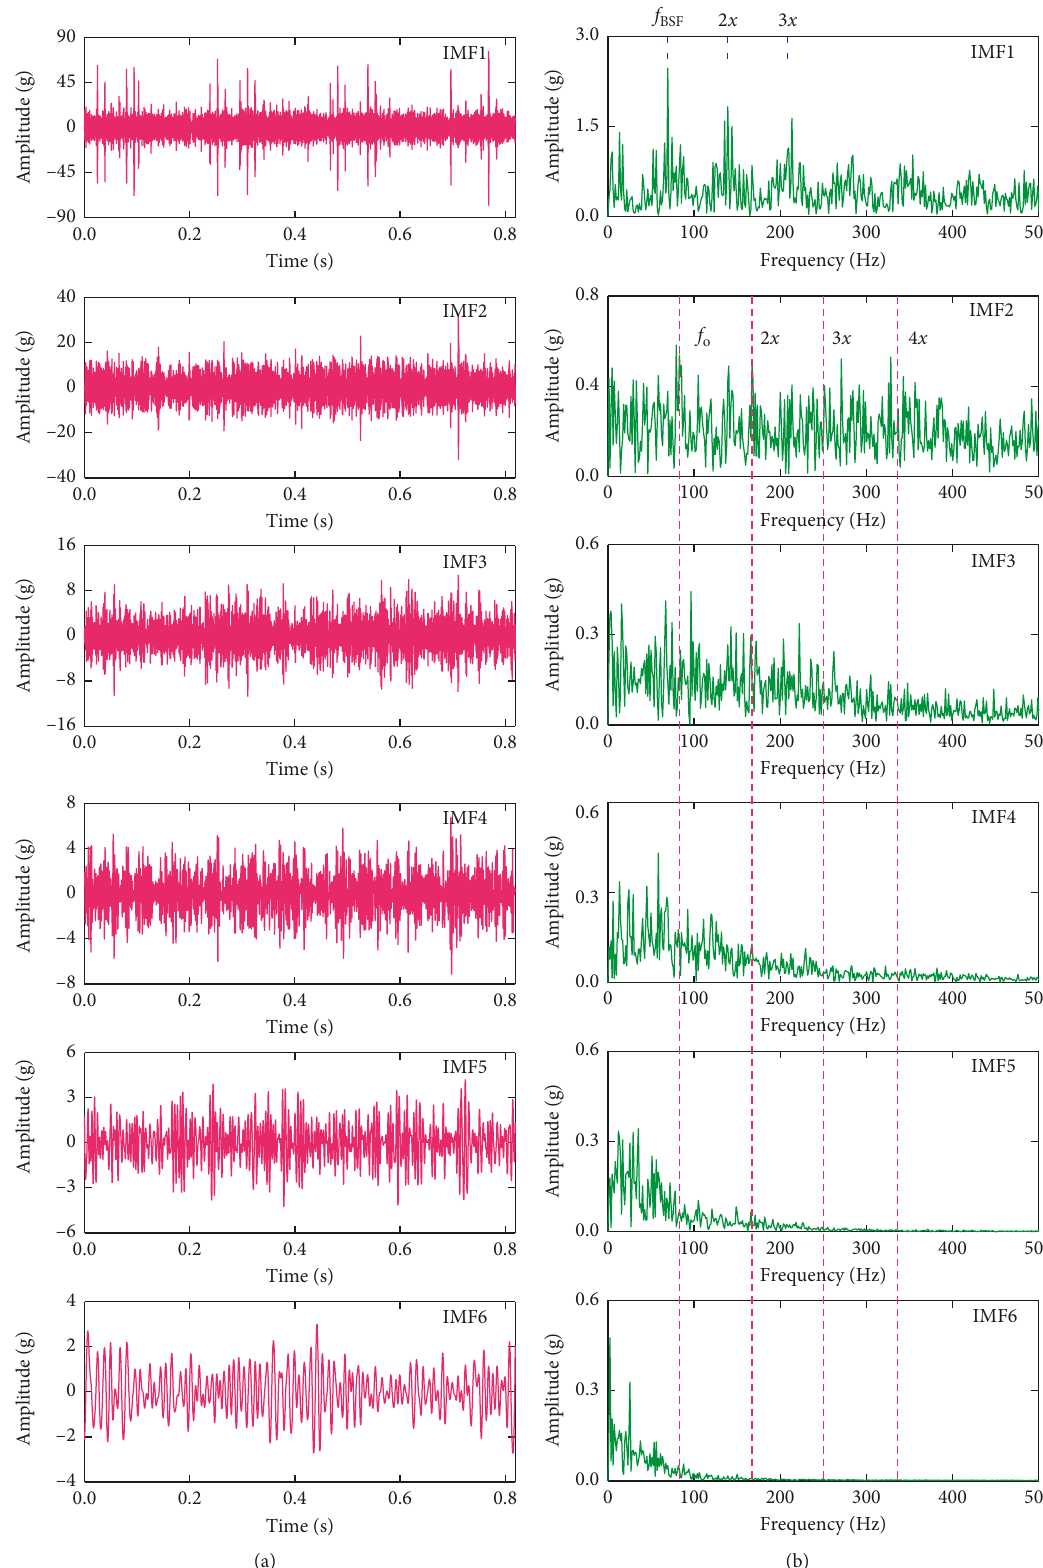
Figure 15: Results obtained using EEMD: (a) time-domain waveform; (b) Hilbert envelope spectrum of